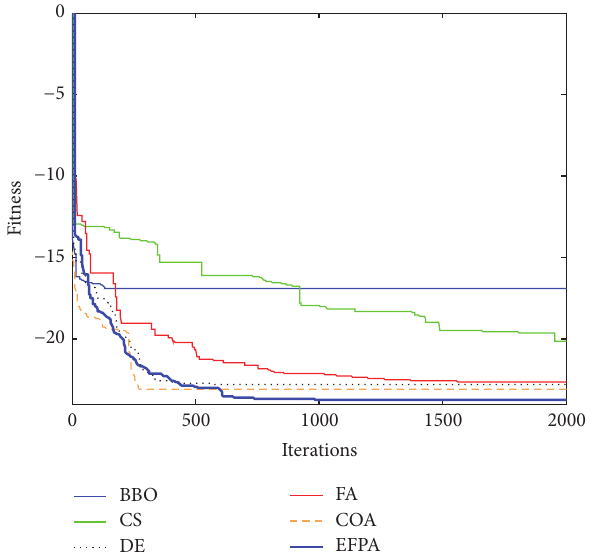
Figure 8: Convergence plots of 32-element LAA.